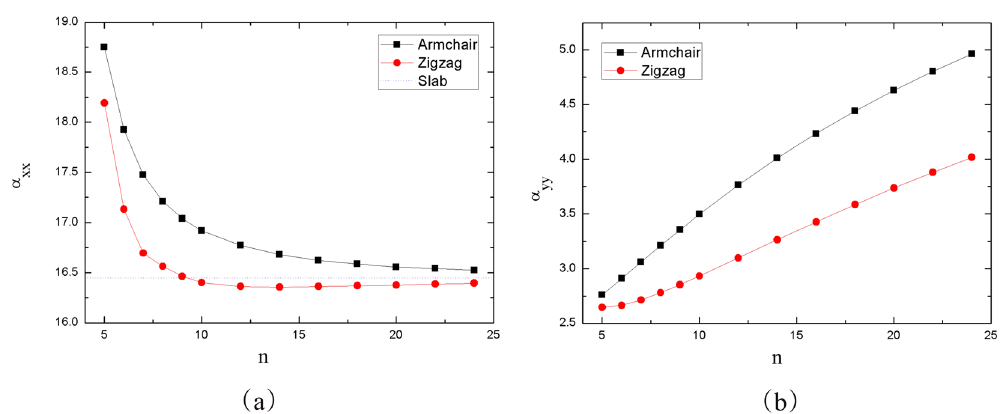
Figure 9. ( a ) α xx and ( b ) α yy per P as a function of n for two types of